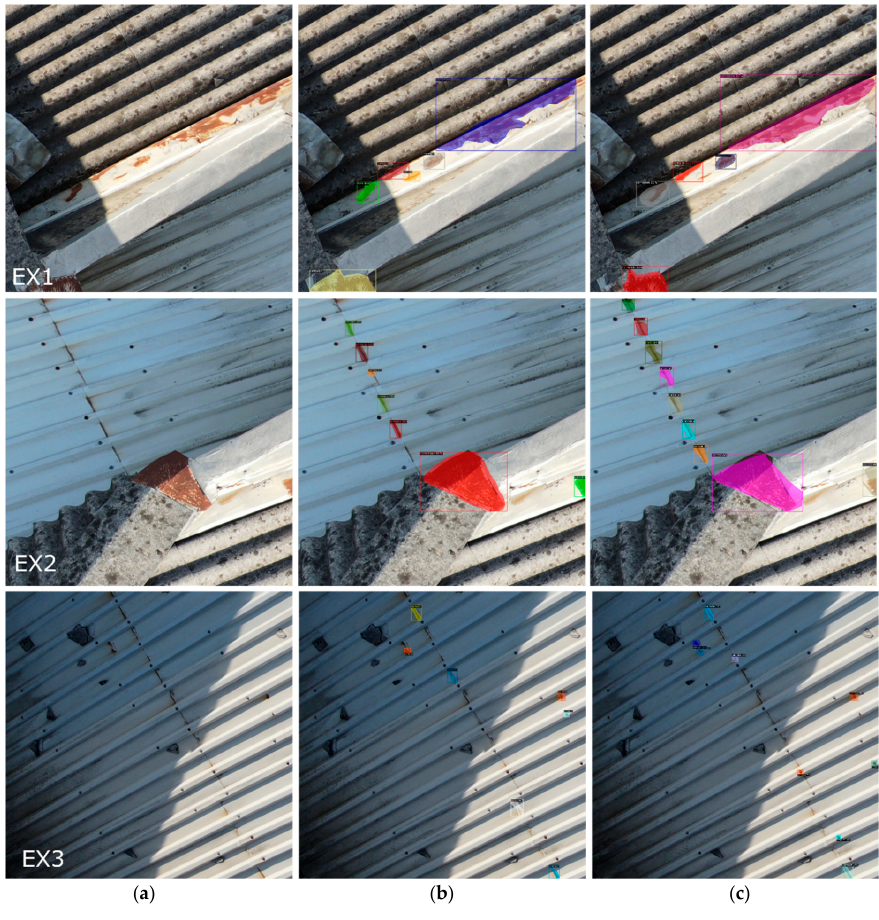
Figure 17. Examples of classification with complex backgrounds (EX1 to EX3): ( a ) original image, ( b ) ground truth, and ( c ) prediction.